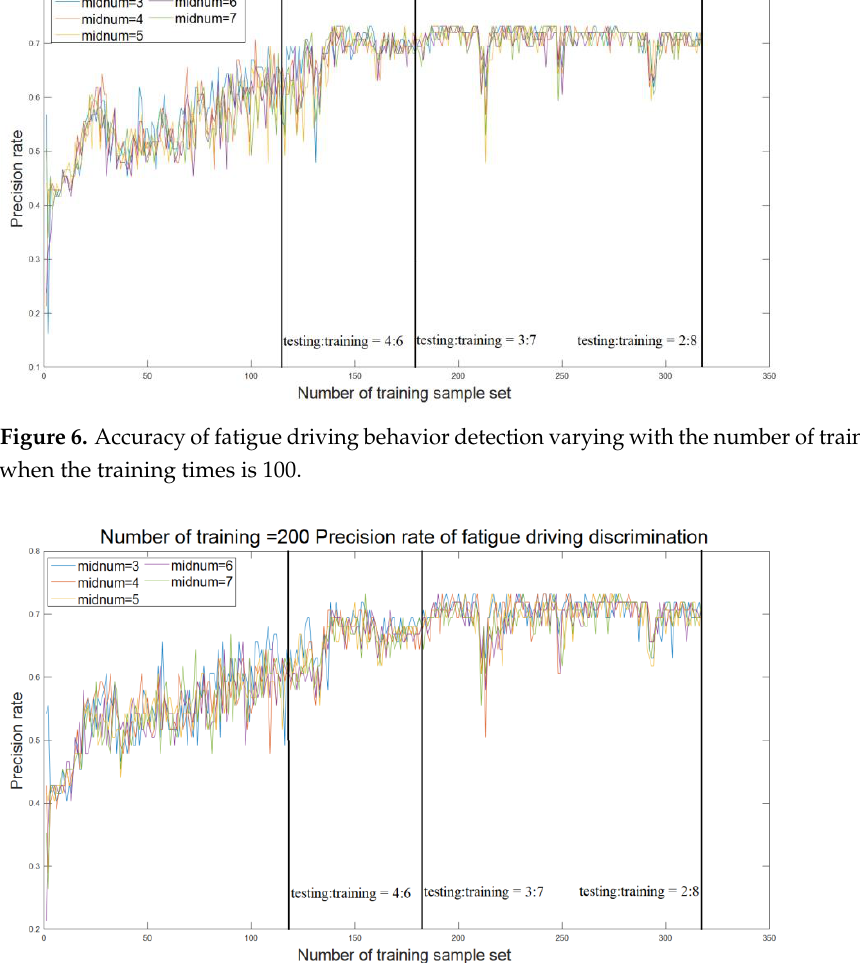
Figure 7. Accuracy of fatigue driving behavior detection varying with the number of training samples when the training times is 200.